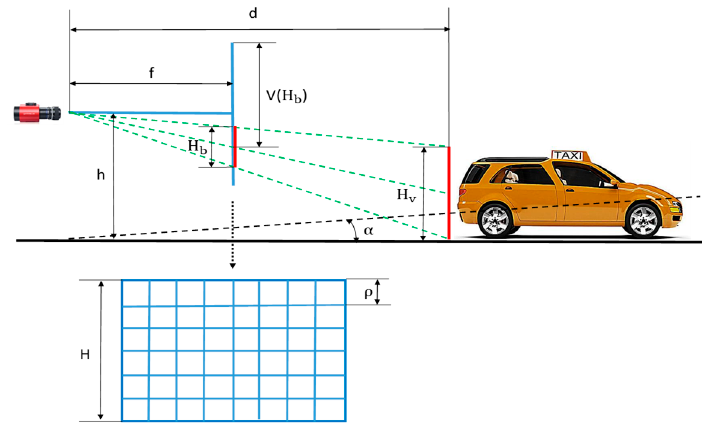
Figure 4. Illustration of the values in equations. Sensors 2019 , 19 , x FOR PEER REVIEW